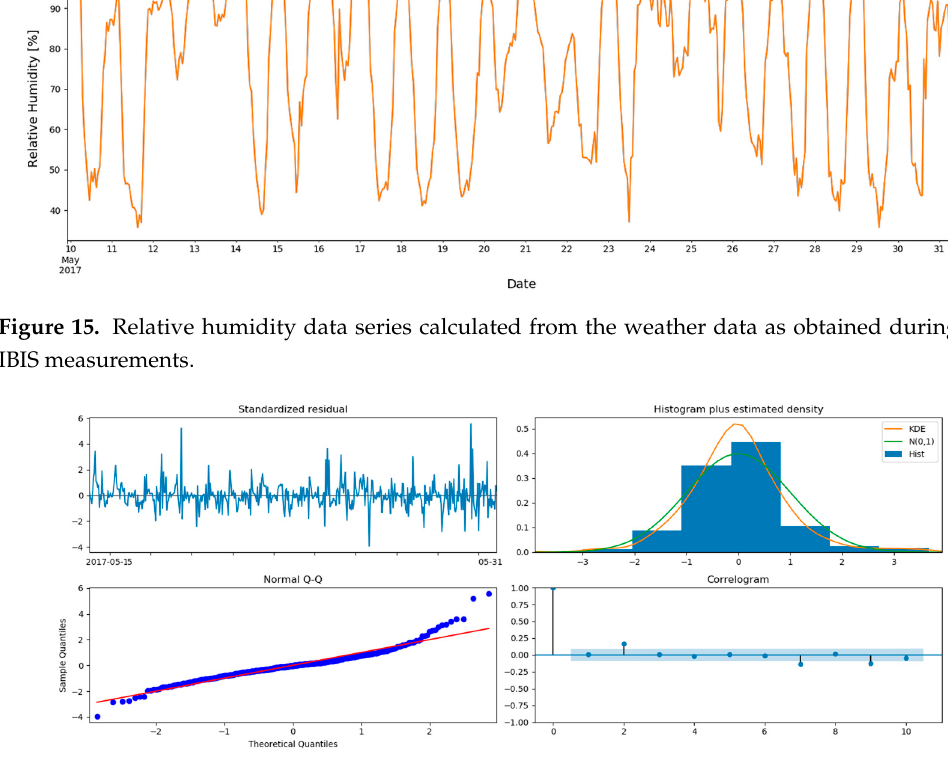
Figure 16. Diagnostic plots for the relative humidity series obtained during the IBIS measurements for the SARIMAX (1, 0, 1) × (0, 1, 1) 24 model.